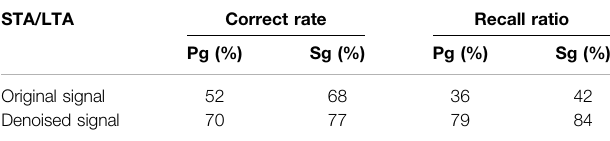
TABLE 3 | Comparison of the seismic phase acquisition results of the original and denoised signals by STA/LTA. STA/LTA Correct rate Recall